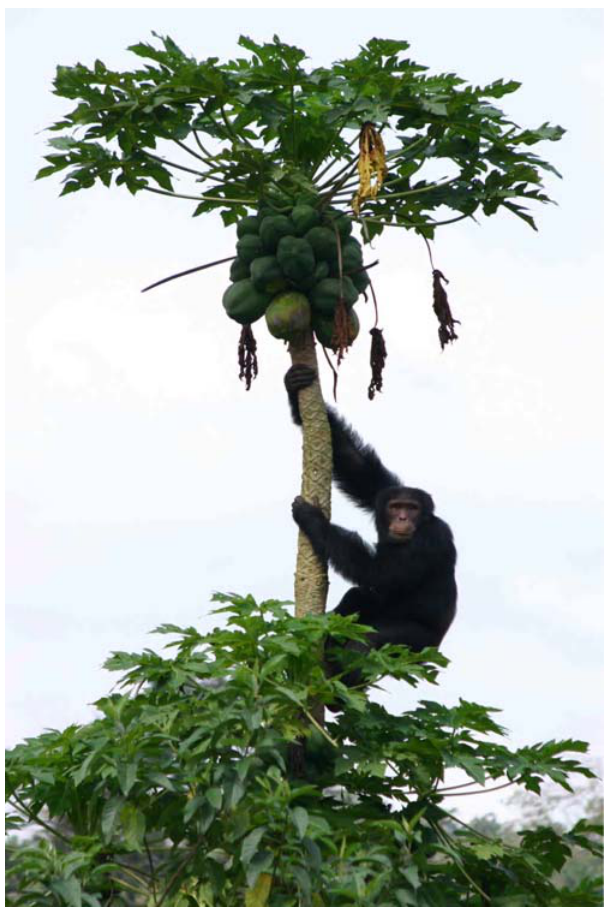
Figure 1. An adult male chimpanzee obtains cultivated papaya fruit.